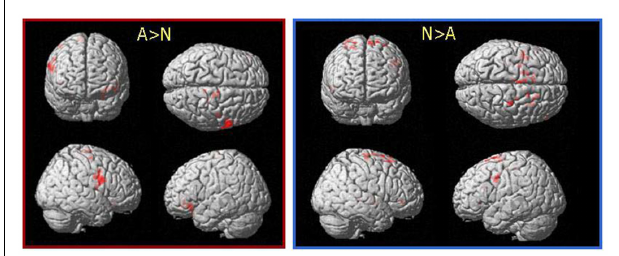
FIGURE 4 | Differential activation between conditions during successfully inhibited Stop-trials; SPM5; ROI; p < 0.05, uncorrected on voxel